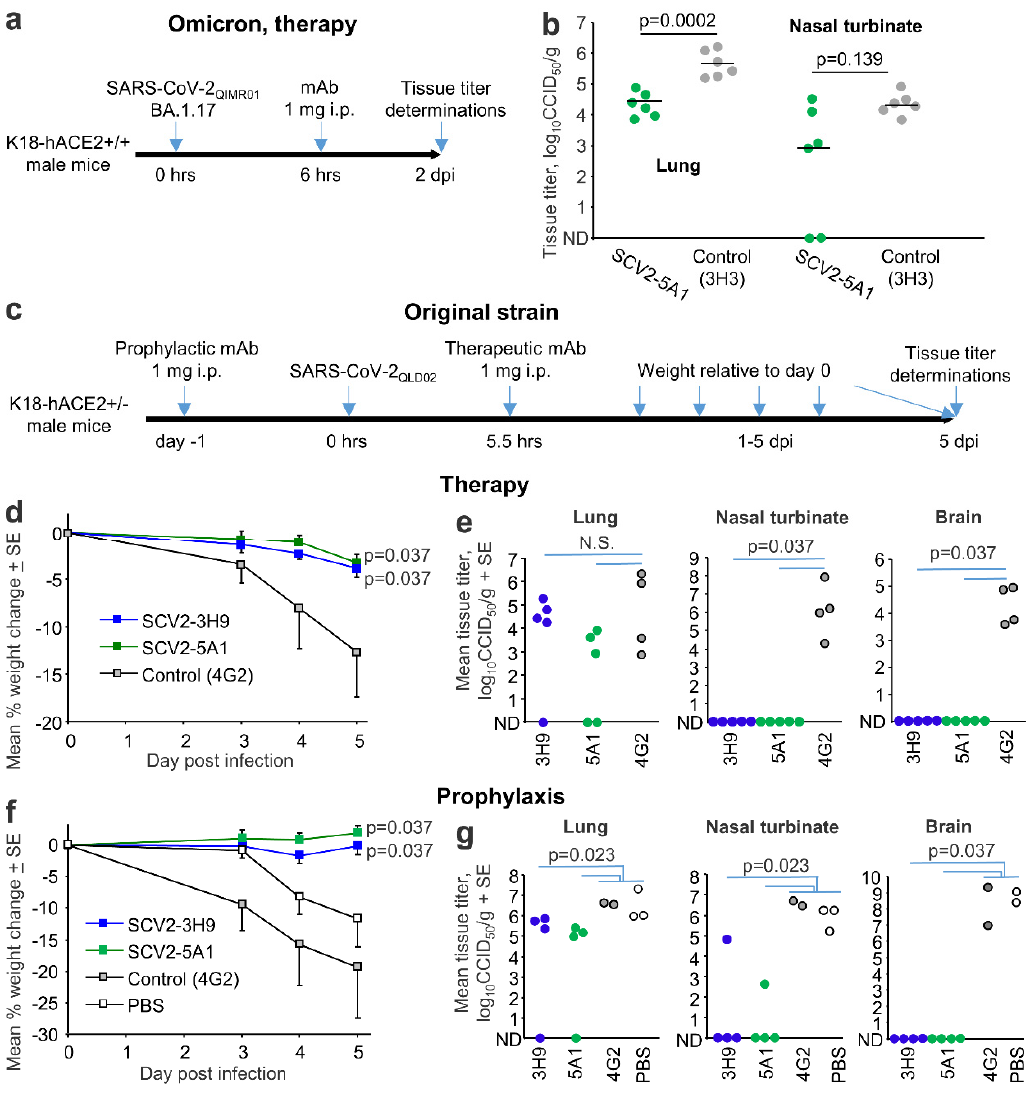
Figure 6. Protection in K18-ACE2 mice. ( a ) Timeline of mAb therapy of K18-ACE2 +/+ mice